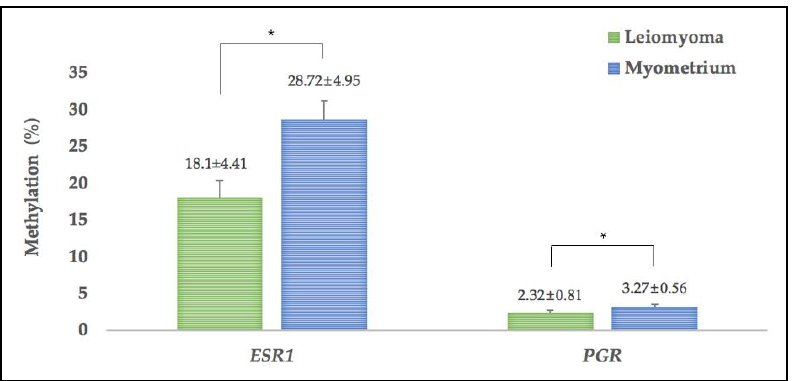
Figure 1. Methylation levels of ESR1 and PGR in leiomyoma and myometrium tissues. Data indicate mean ± standard deviation, and * p < 0.05.